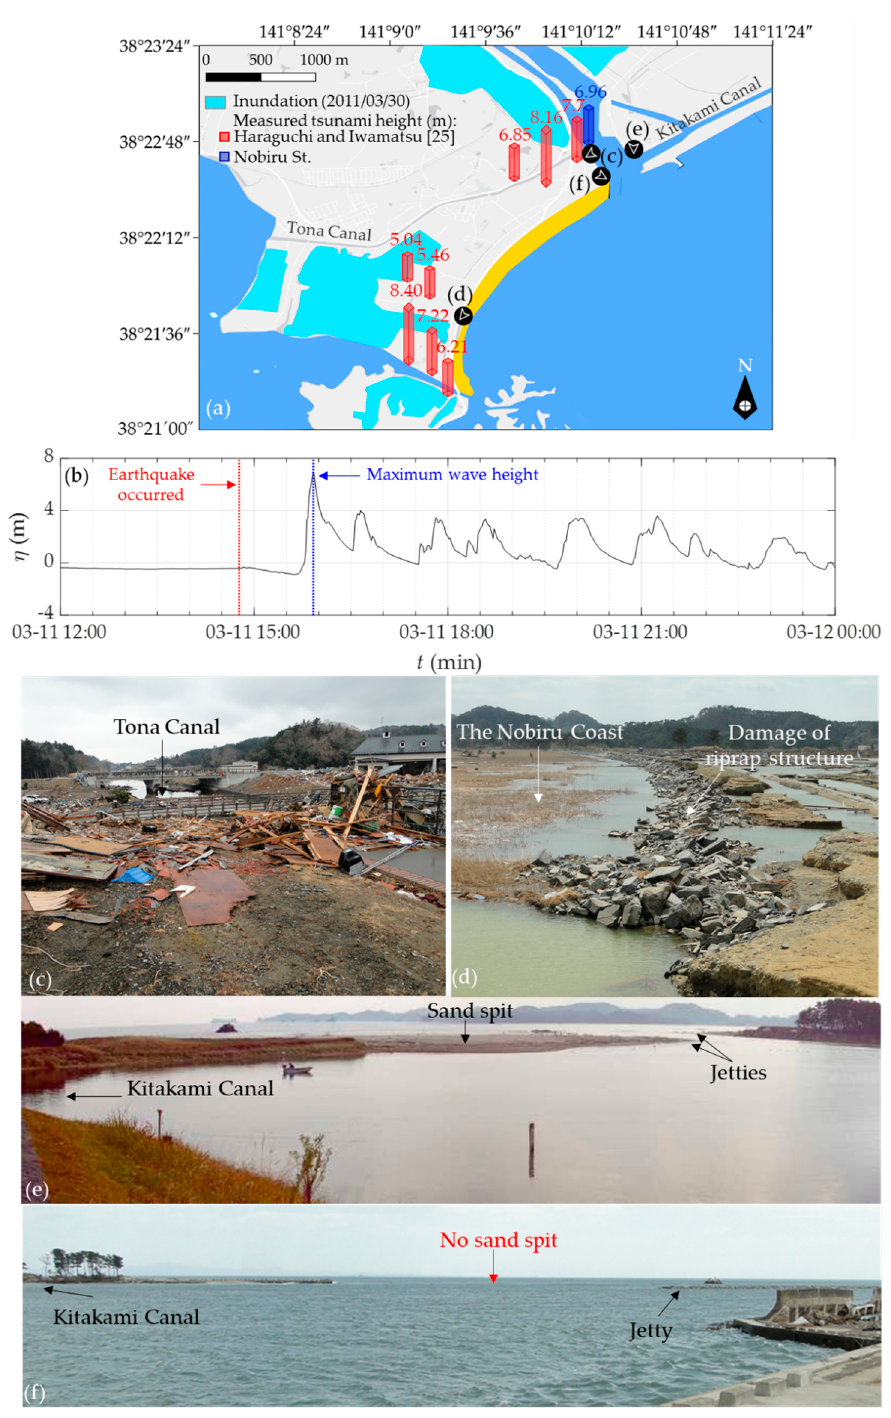
Figure 5. ( a ) Measured tsunami wave heights in the Nobiru Coast and Naruse River mouth (Datum: Tokyo Peil). ( b ) One-minute measured water level in Nobiru Station (Datum: Tokyo Peil). ( c ) Collapses of infrastructure in the Tona Canal (Captured: 18 April 2011). ( d ) Damage of coastal structure (Captured: 18 April 2011). ( e ) Existence of the sandspit before the 2011 tsunami (Captured: May 2002). ( f ) Disappearance of the sandspit after the 2011 tsunami (Captured: 18 April 2011).